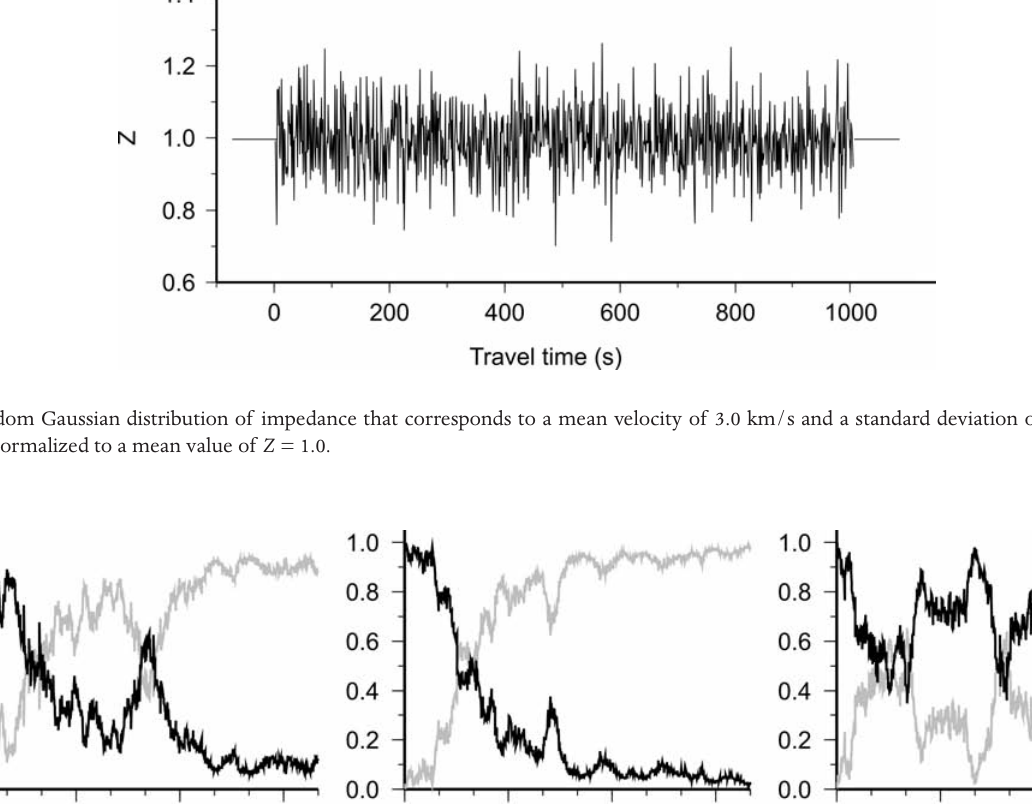
Figure 8. Wave attenuation in three statistical realizations of impedance time series (see Figure 7) for frequency f = 0.2 f transmitted and reflected power,